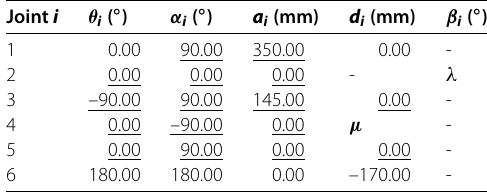
Table 2 Denavit-Hartenberg and Hayati zero offset values with λ ∈ { 650,700,...,1,050 } and μ ∈ { 600,650,...,1,050 }